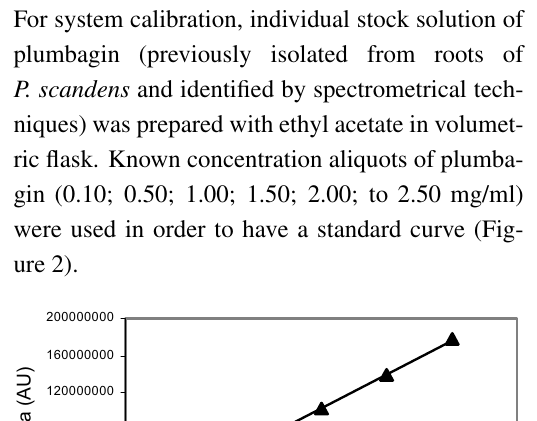
Table I. The lowest level of this substance was ob- served in the extract obtained by static